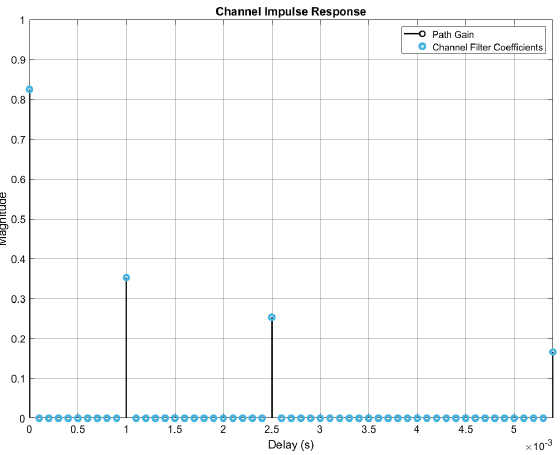
Figure 3. Channel impulse response for a shallow underwater acoustic channel.